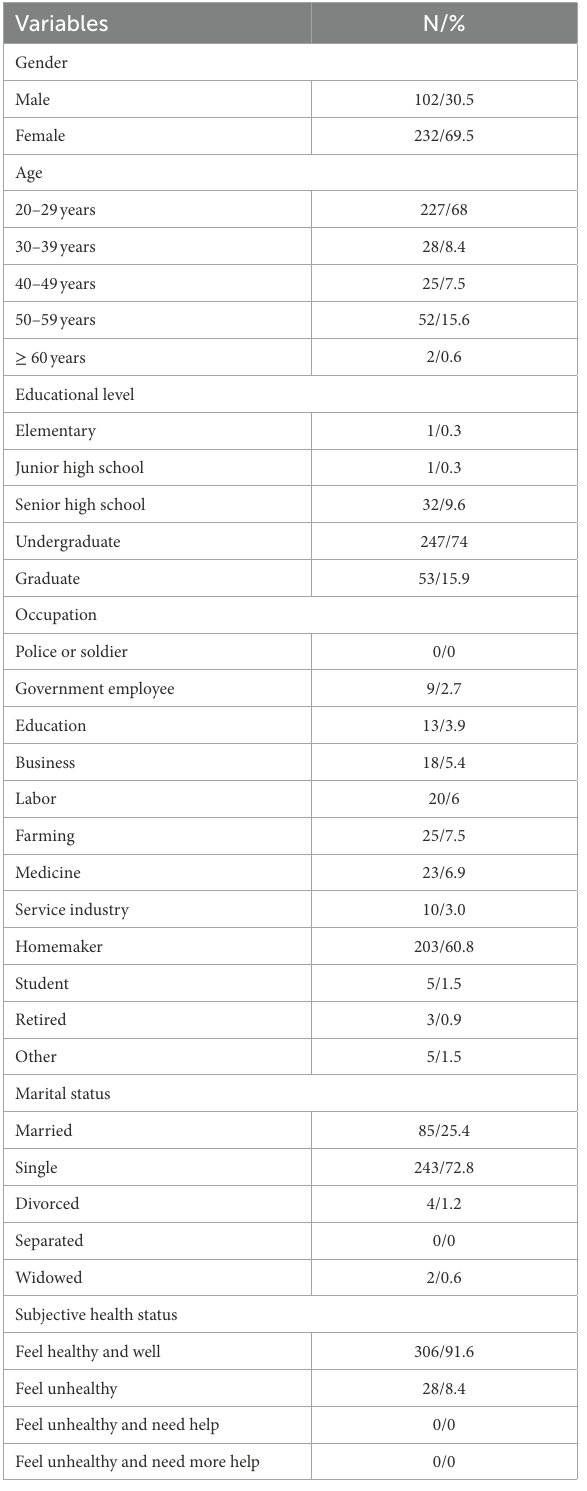
TABLE 1 Distributions of demographic and measured